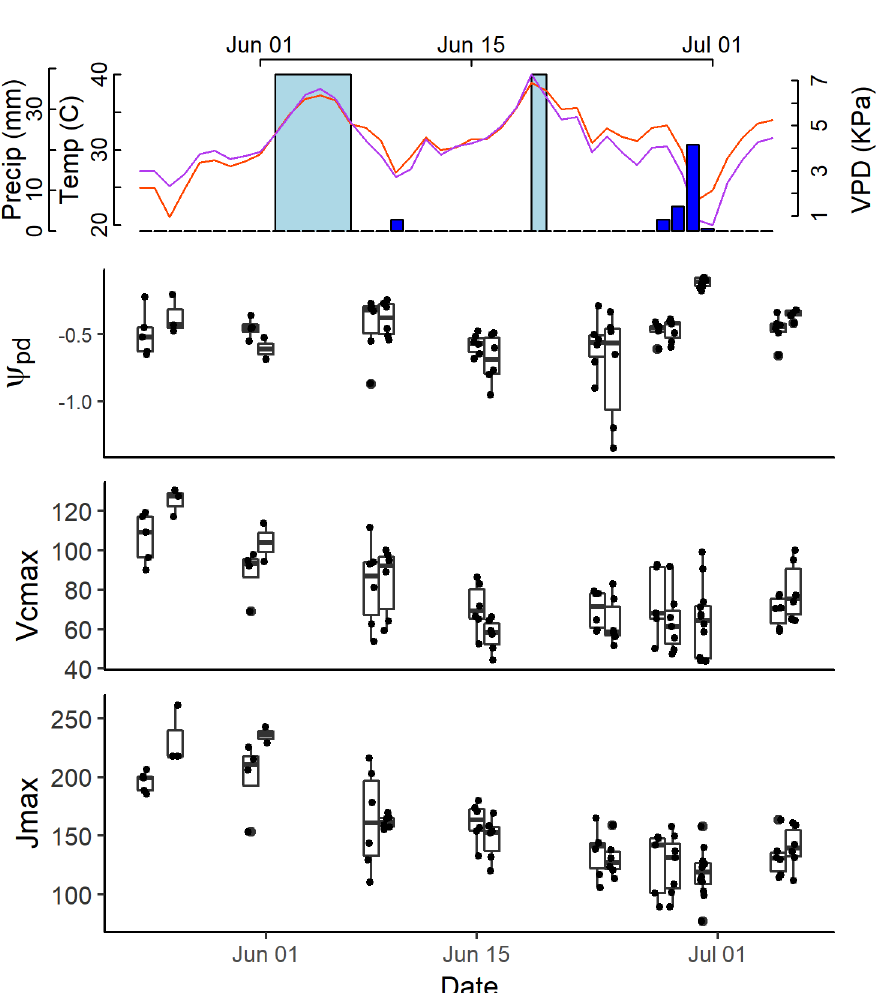
Fig 1. Temporal variability in meteorological and physiological conditions throughout the study period. A) shows mean daytime temperature in ˚C (orangeline; 06:00 to 18:00), peak VPD in kPa (purple line; 10:00 to 14:00), precipitationin mm and supplemental watering throughoutthe study periodwith dark blue bars representing precipitationand light blue representingsupplemental wateringdays. B) Shows the time series of predawnwater potential(MPa) throughoutthe study period. C) and D) show the time series of estimated